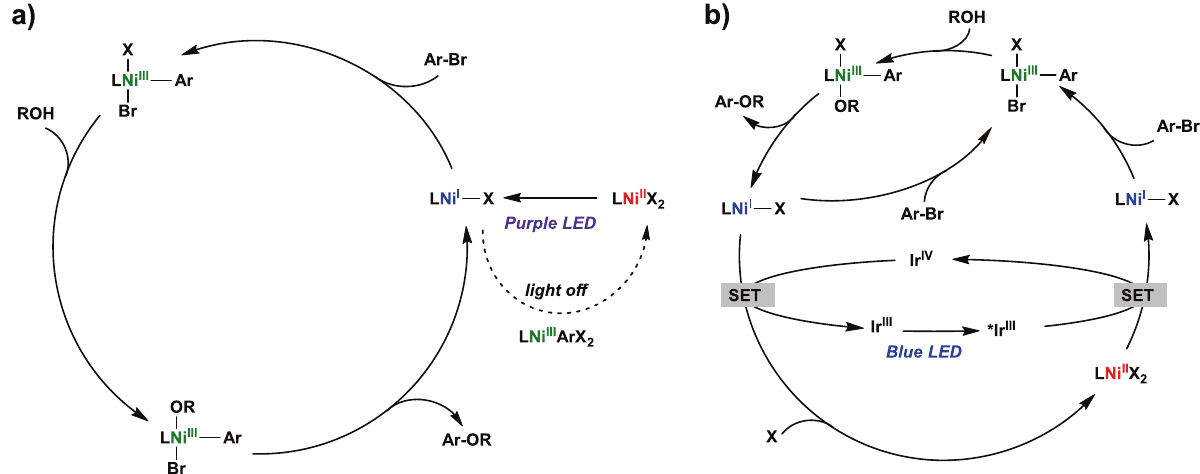
Fig. 7 Proposed photocatalytic mechanisms. Proposed mechanisms for the C – O cross coupling reaction for a direct light-promoted Ni catalysis with purple LED light (proposed catalyst inactivation pathway in absence of light is shown in dashed arrow), and b dual Ni/photoredox catalysis with blue LED light. X = Cl or Br, L = Me N3 or iPr